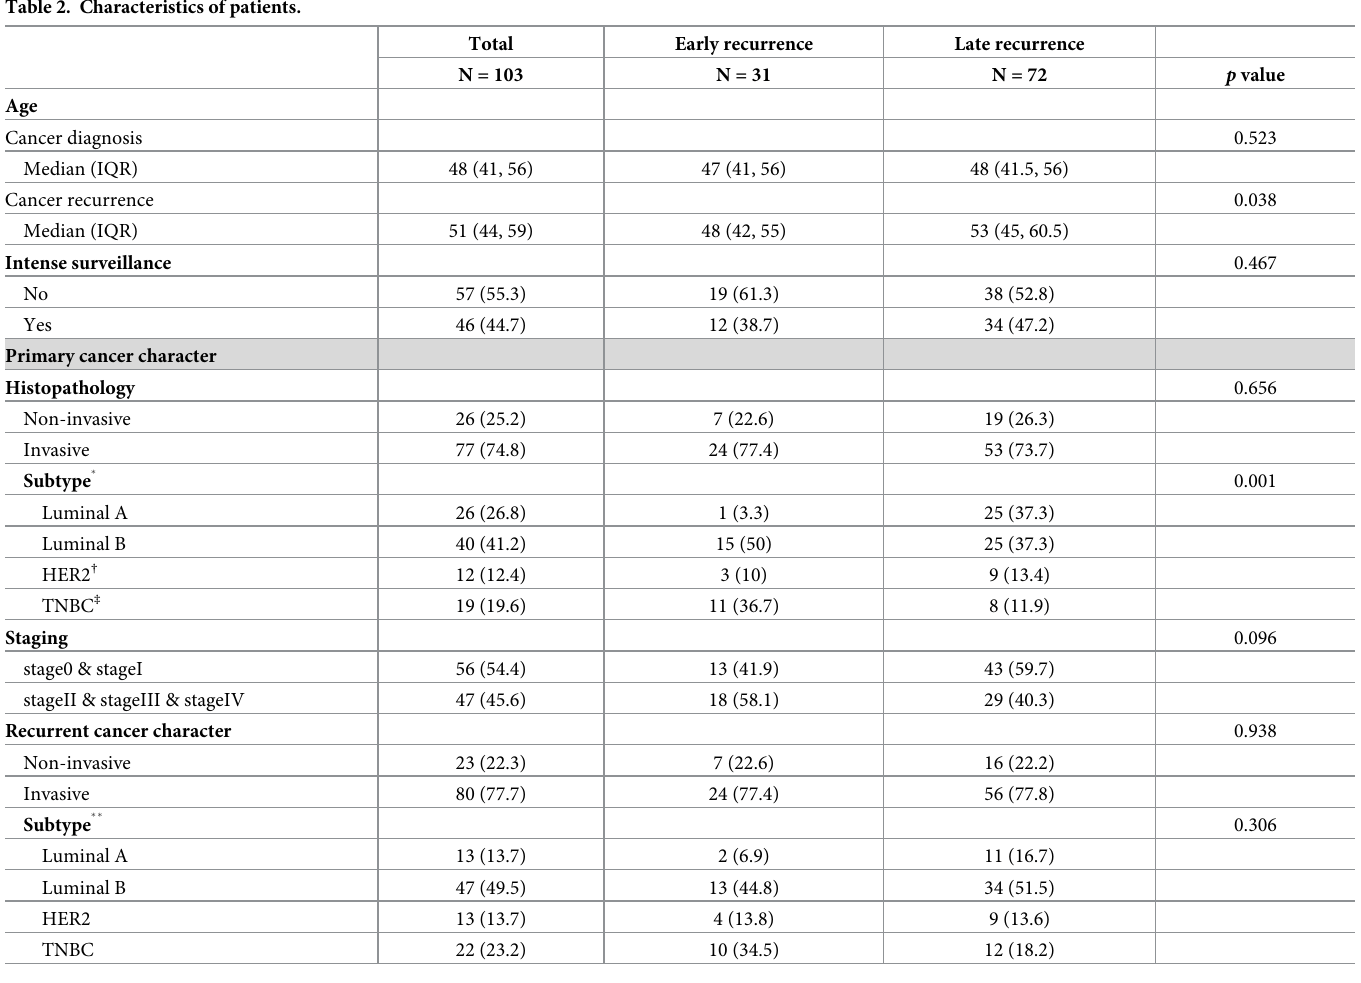
Table 2. Characteristics of